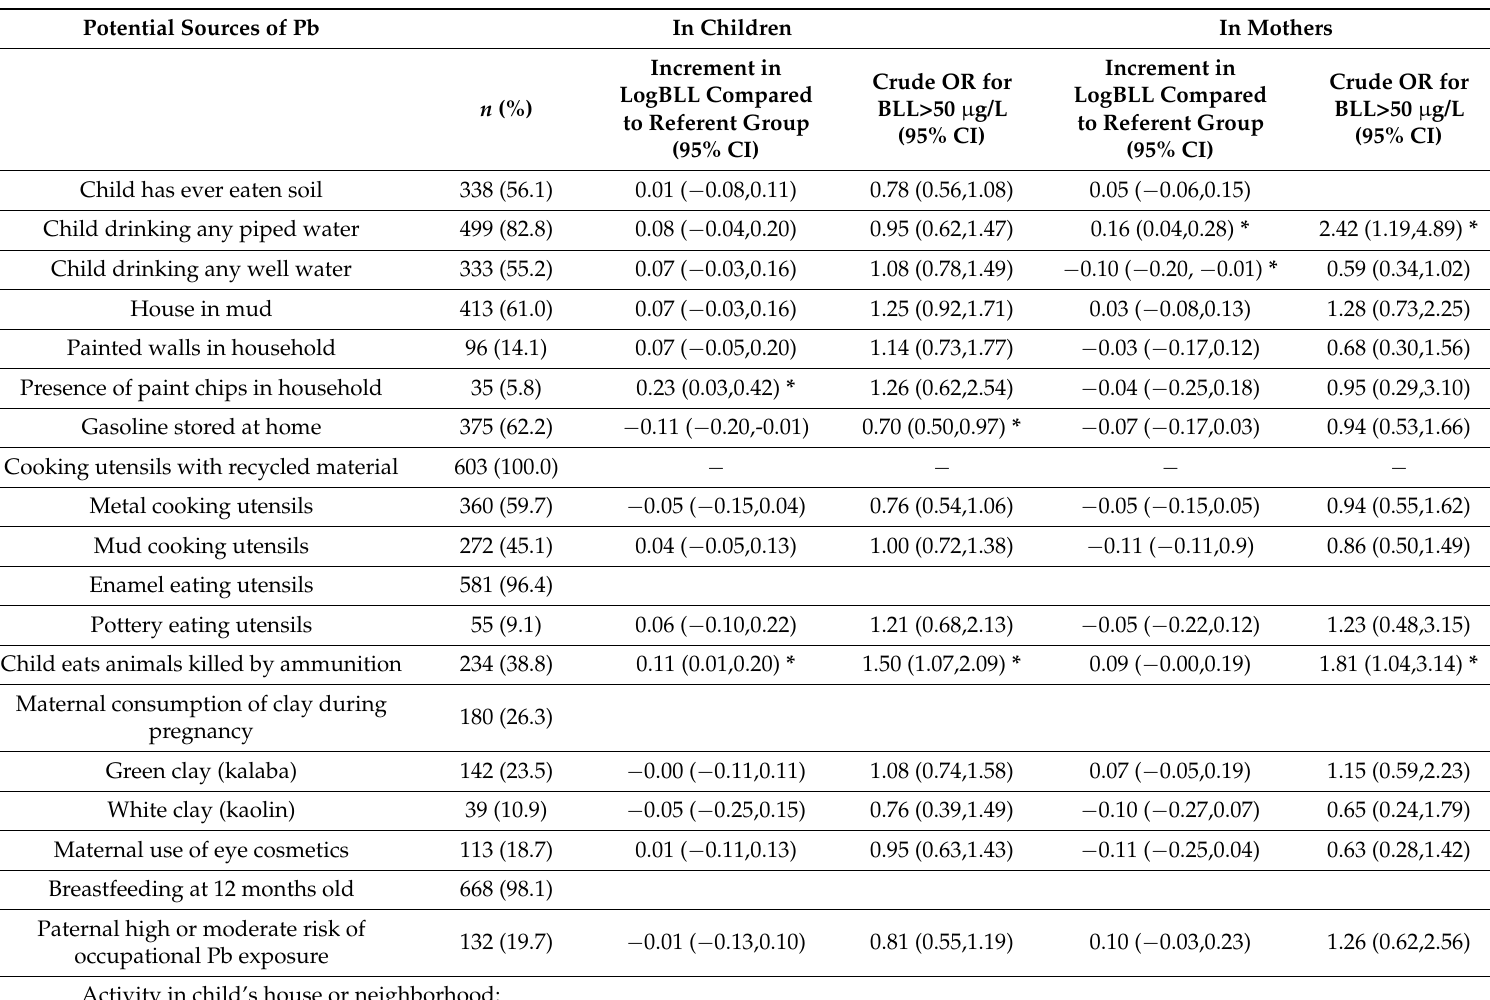
Table 2. Univariate analysis of potential sources of lead (Pb) and BLL in children and mothers. Potential Sources of